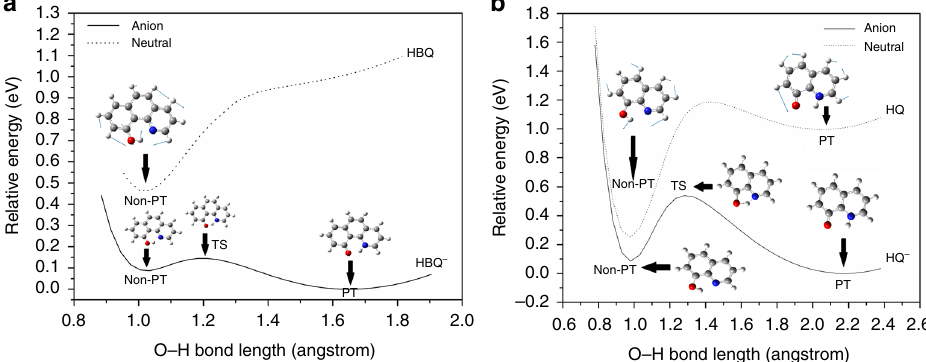
Fig. 3 Potential energy surfaces. Potential energy surfaces of HBQ 0/ − ( a ) and HQ 0/ − ( b ) along the O − H coordinate using the relaxed scan method. PT proton-transferred, Non-PT non-proton-transferred, TS transition